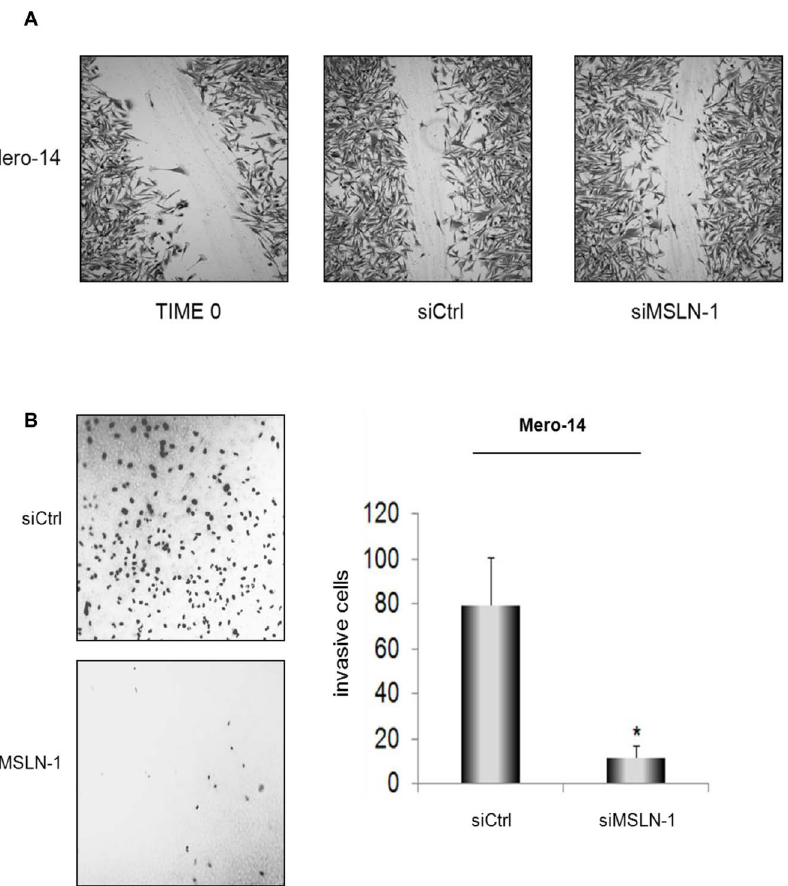
Figure 4. Role of MSLN in cellular migration and invasion. A . No effects observed in the wound-healing assay, following siRNA transfections. Confluent monolayers of Mero-14 cells transfected with 40 nM of siCtrl, or siMSLN-1, respectively. Two different experiments were carried out, each performed in triplicate. B . Trans-well cell invasion assay on Mero-14 cells transfected with 40 nM of the siCtrl (top), or siMSLN-1 (bottom). Pictures were taken using a fluorescence microscope at 10X magnification and are reported as negative of the originals to enhance the contrast between the background and the DAPI-stained cells. The bar chart shows the average of invasive cells (error bars represent SEM of two independent experiments, each done in triplicate, *P = 0.0044).